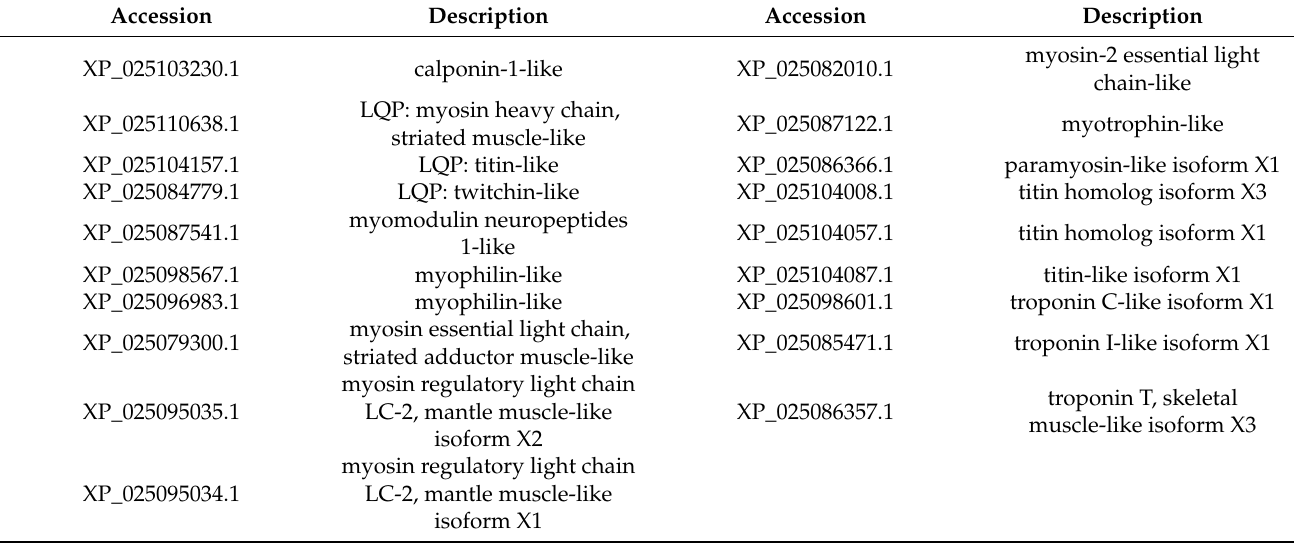
Table 1. List of proteins related to contractile